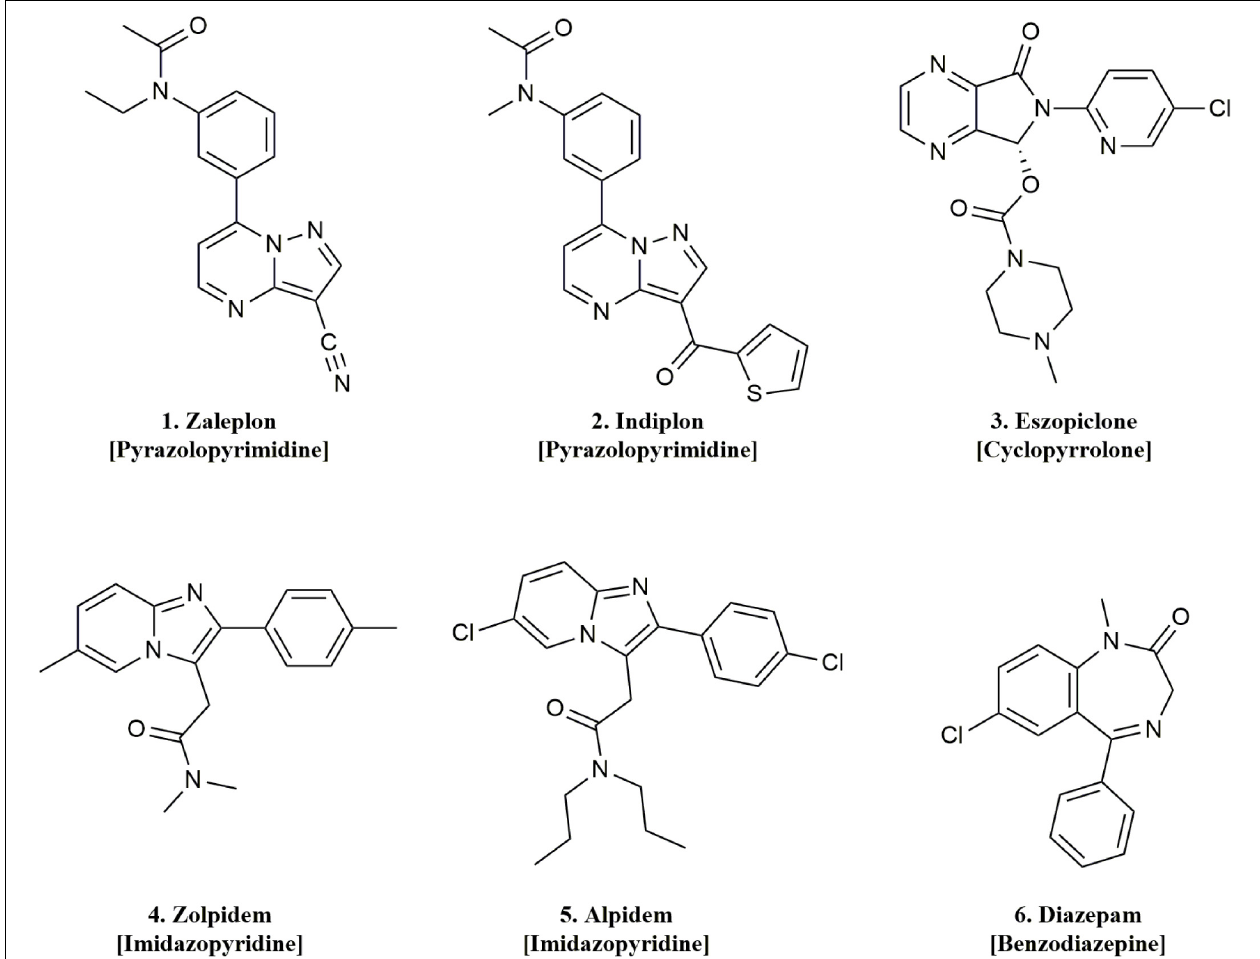
FIGURE 2 | Chemical structures and classes of the drugs used in this study.